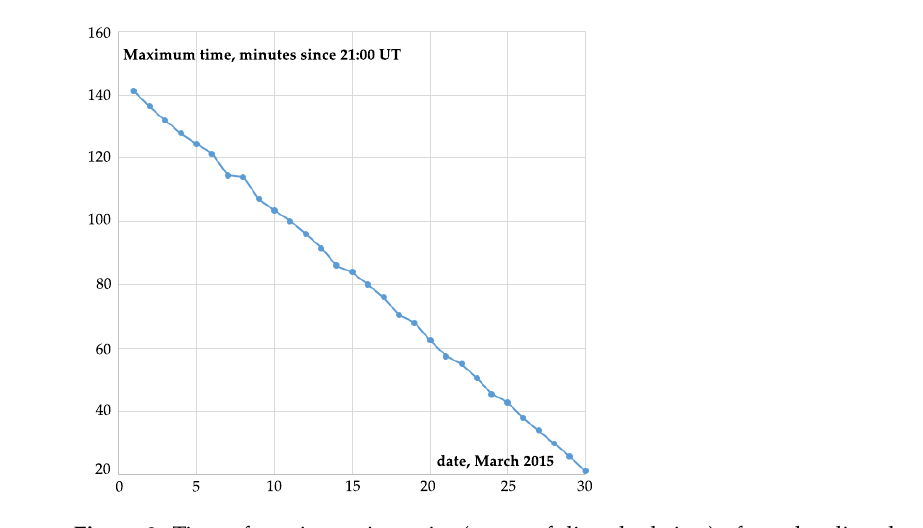
Figure 3. Time of maximum intensity (count of disturbed sites) of regular disturbances. Average change of maximum time was 4 min 8 s per day.